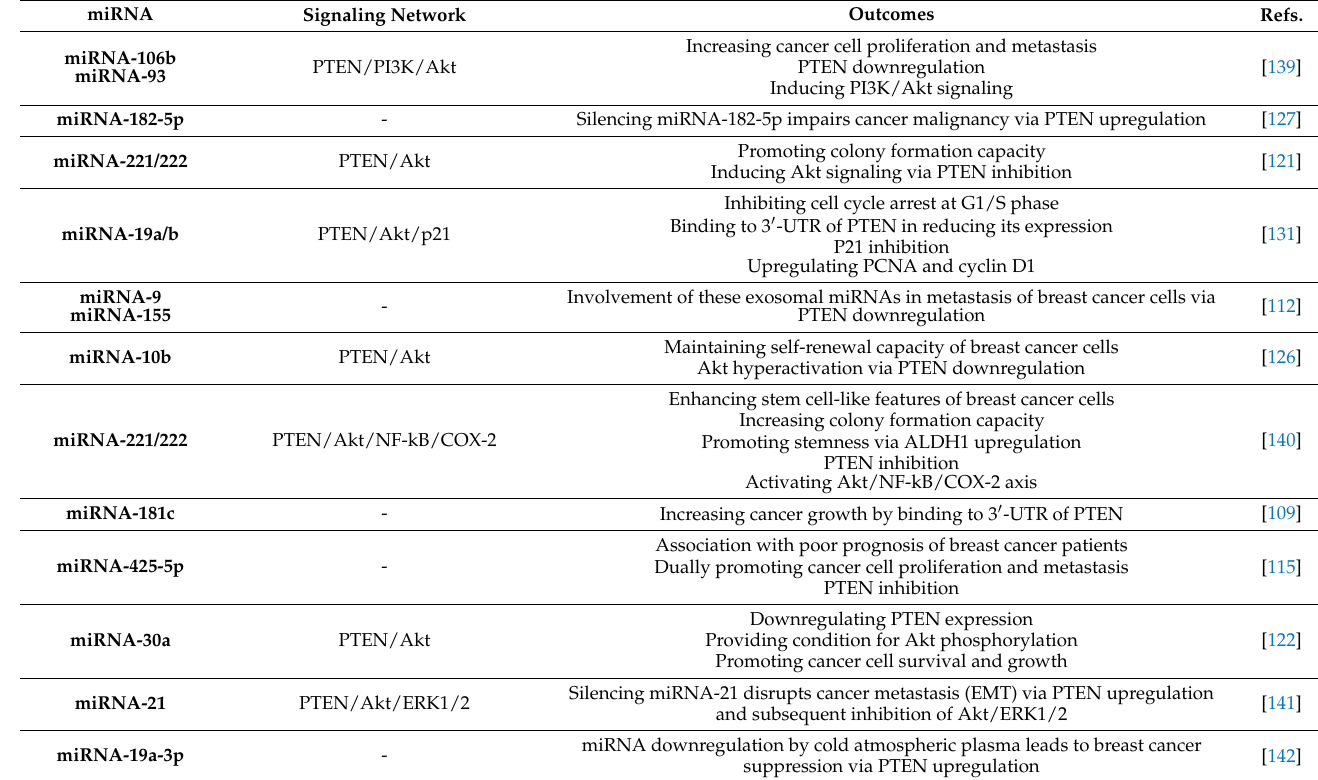
Table 1. MicroRNAs (miRNAs) inhibiting PTEN in promoting breast cancer